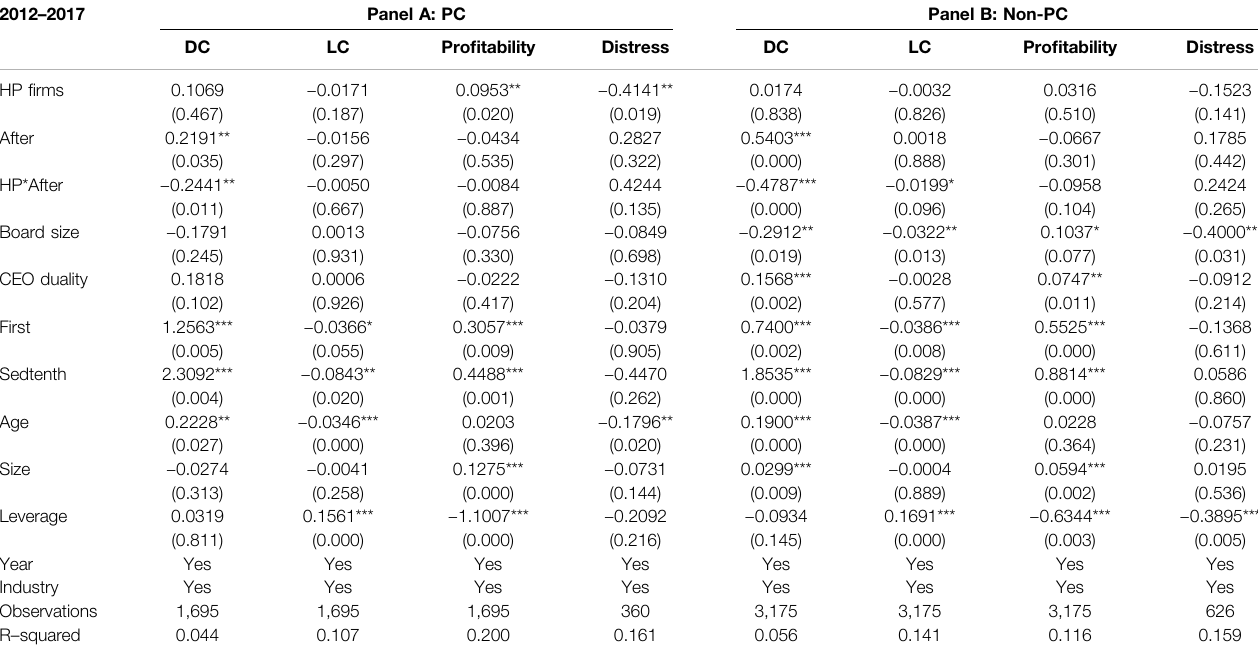
TABLE 10 | Subsample tests-Politically connected and non-connected fi rms. Thistablepresentstheresults ofsub-sampletests: Politically connectedand non-connected fi rms.We de fi nea fi rm aspoliticallyconnected ifthe CEO orChair ofBoard isor was agovernment of fi cial. For the sample period of2001 – 2006,we fi ndthat the environmental protectionfee has insigni fi cantin fl uence on fi rm performance for various sub-samples. In this case, we only report the results of the sample period of 2012 – 2017 in this section for brevity purpose. For the probit regression (column Distress), we report the marginal effect rather than the coef fi cients. For the de fi nitions of variables refer to Appendix A . P -values are in